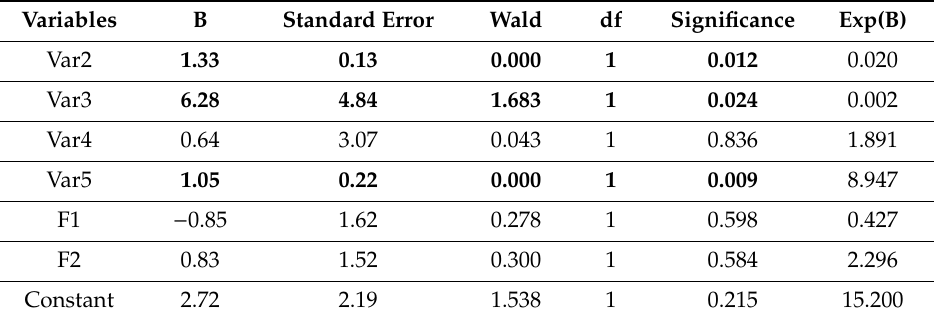
Table 9. Estimation of the value of parameters of the logistic regression